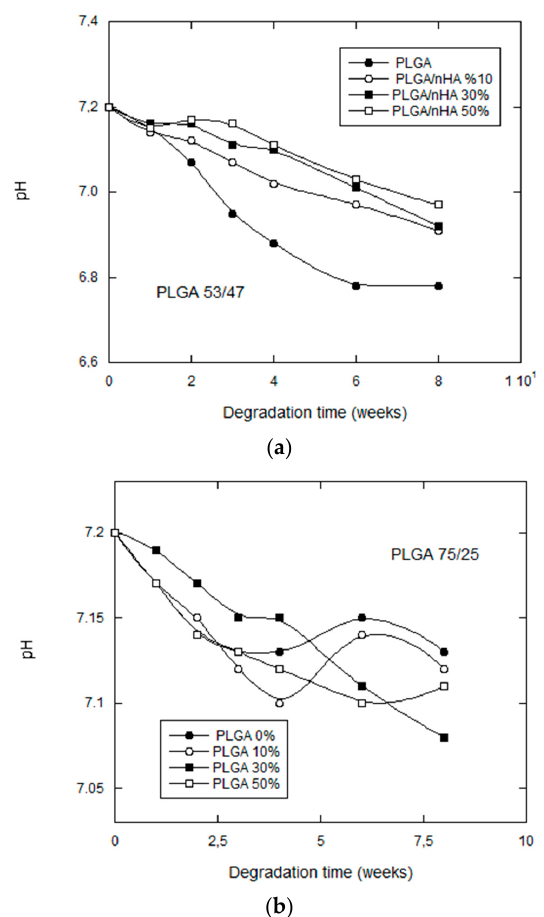
Figure 5. pH change of phosphate-buffered solution for: ( a ) PLGA (53/47)/nHA; and ( b ) PLGA (75/25)/nHA composite scaffolds against degradation time.